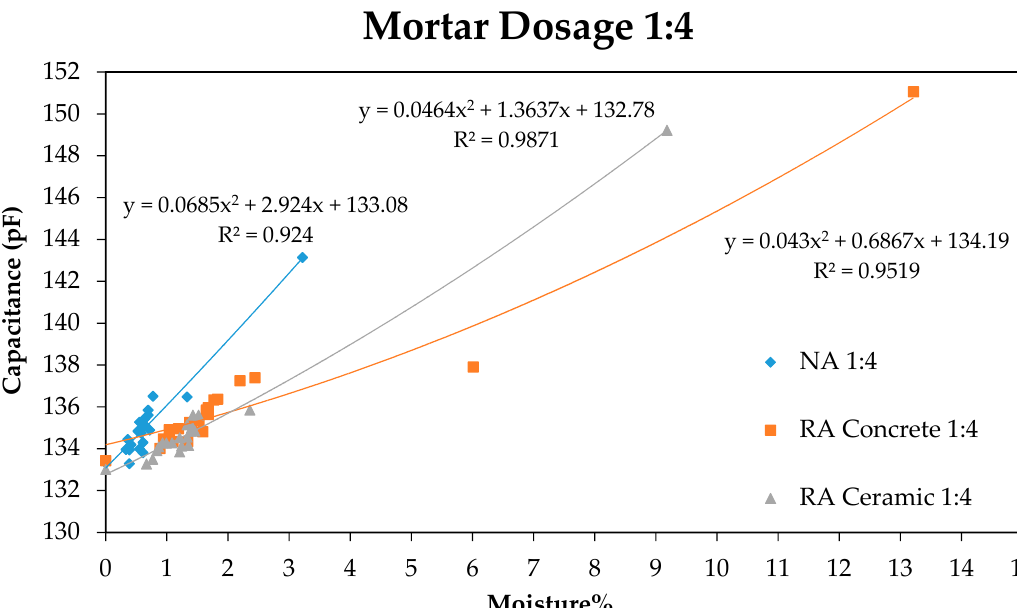
Figure 3. Relation Moisture–Capacitance for mortars with 1:3 dosage.